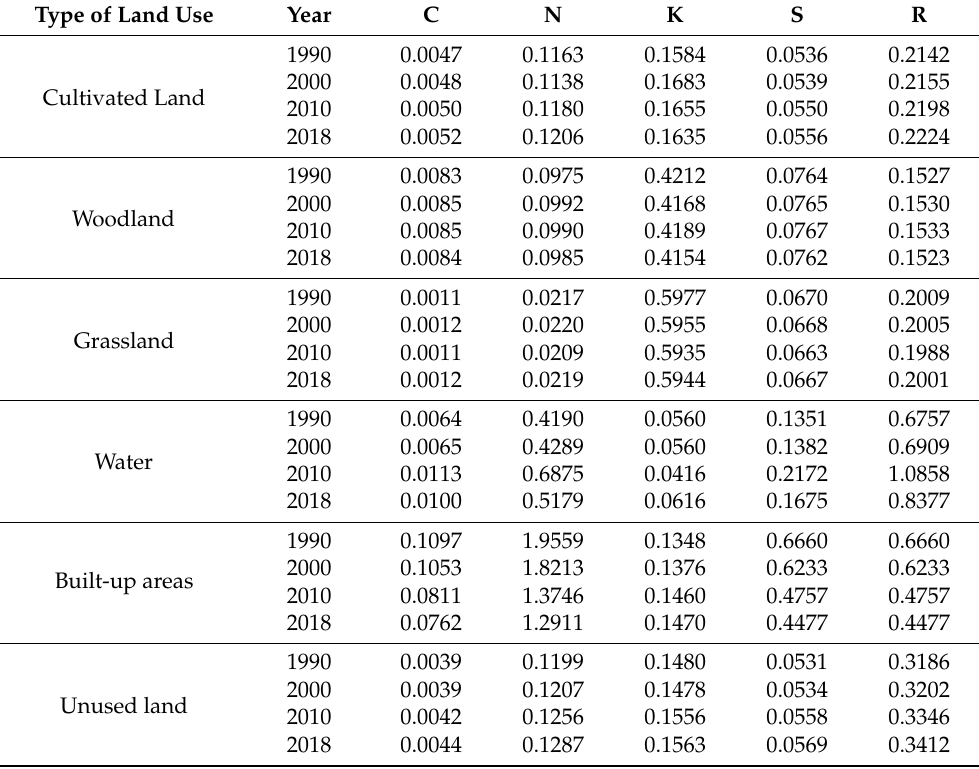
Table 3. Changes in the fragmentation degree (C), the separation degree (N), the dominance degree (K), the interference degree (S), and the loss degree(R).